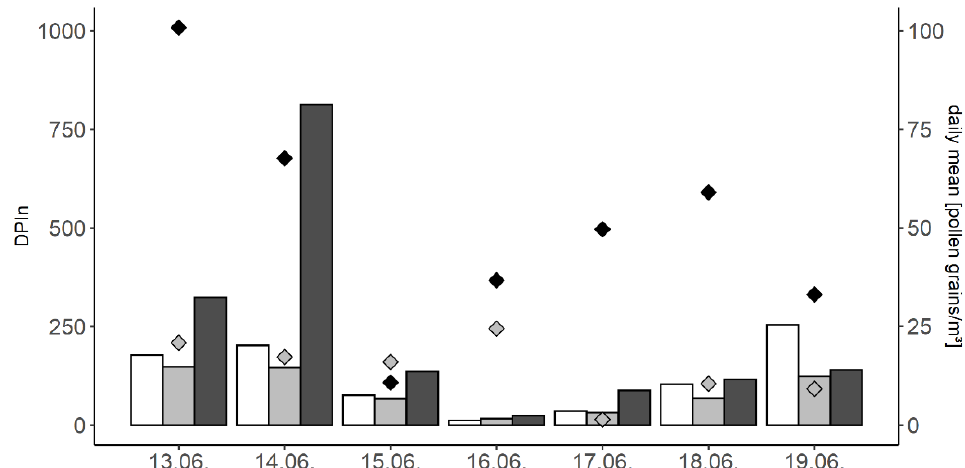
Figure 7. Sum of DPIn PVAS for locations in urban area/city centre (U; white), residential area (R; light grey), and semi-rural environment (SR; dark grey). Squares represent daily mean pollen concentration measured at rooftop level: black—SRS and grey—US.